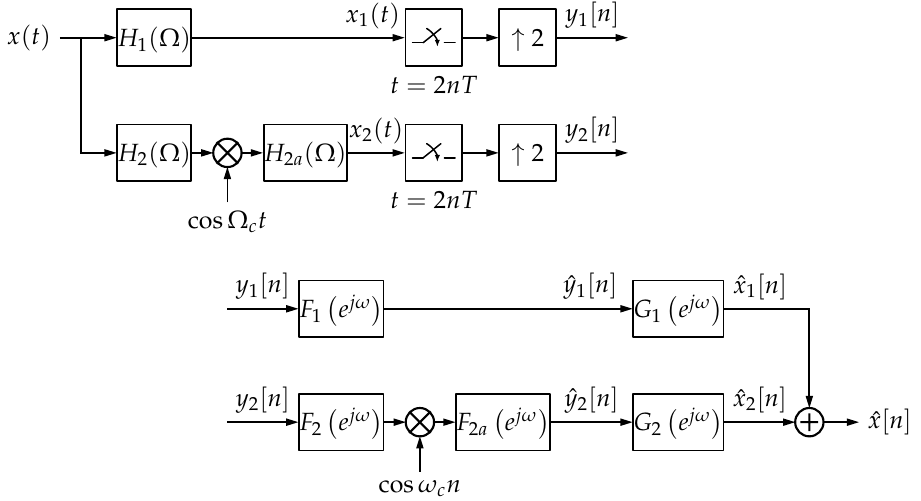
Figure 1. Two-channel digital bandwidth interleaving (DBI) system.